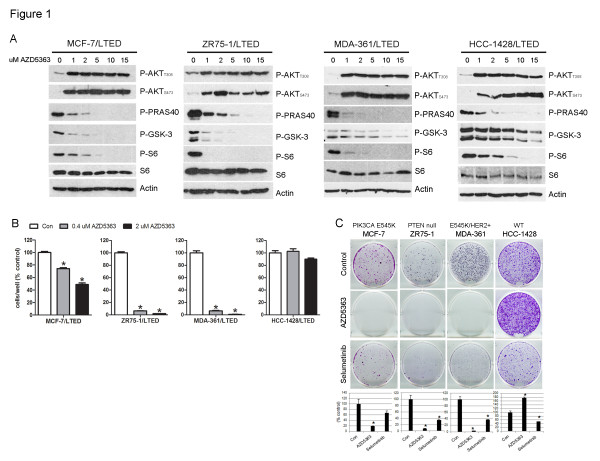
Catalytic AKT inhibitor suppresses LTED growth and prevents emergence of hormone-independent breast cancer cells. A) LTED cells were treated with 10% DCC-FBS ± 0 to 15 µM AZD5363 for 24 hours. Protein lysates were analyzed by immunoblot using the indicated antibodies. B) LTED cells were treated with 10% DCC-FBS ± 0.4 or 2 µM AZD5363. Media and drugs were replenished every three days. Cells were counted after five to ten days. Data are presented as percent of control; each bar, mean ± SEM (n = 3; *P <0.0001 versus Con, one-way ANOVA). C) Parental cells in 10% DCC-FBS were treated with ± 2 µM AZD5363 or 1 µM selumetinib. Media and drugs were replenished every three days. When control monolayers reached 60% to 80% confluency (after 15 (MCF-7), 36 (ZR75-1 and MDA-361) or 38 (HCC-1428) days, respectively), cells were fixed and stained with crystal violet. Representative images and quantification of integrated intensity (% control) are shown (*P <0.05 versus control, t-test). ANOVA, analysis of variance; DCC-FBS, dextran/charcoal-treated fetal bovine serum; LTED, long-term estrogen deprivation; SEM, standard error of the mean.